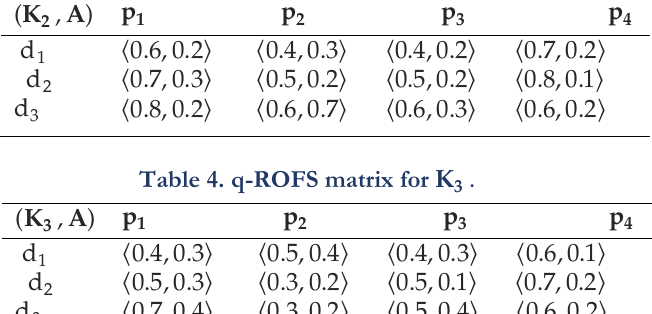
Table 5. q-ROFS matrix for 𝐊